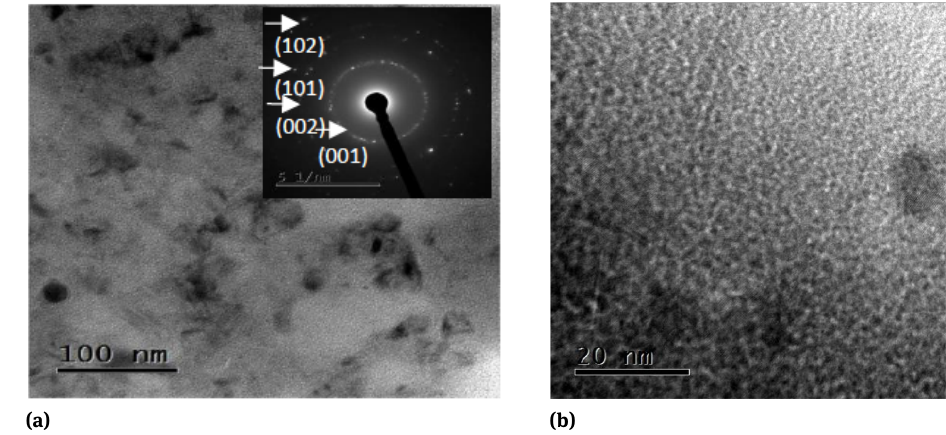
Figure 29: TEM microstructure of Al-Si-N film showing (a) nanocrystallites in amorphous matrix (b) structure of matrix area